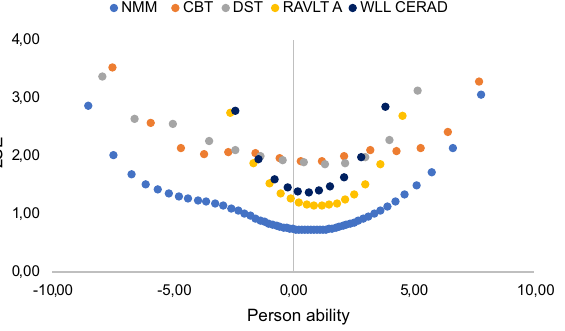
Figure 4. Measurement uncertainties, 2SE, on the y-axis and person ability measures (θ) on the x-axis compared for measures based on the NMM (lowest blue dots) and each of the legacy tests.